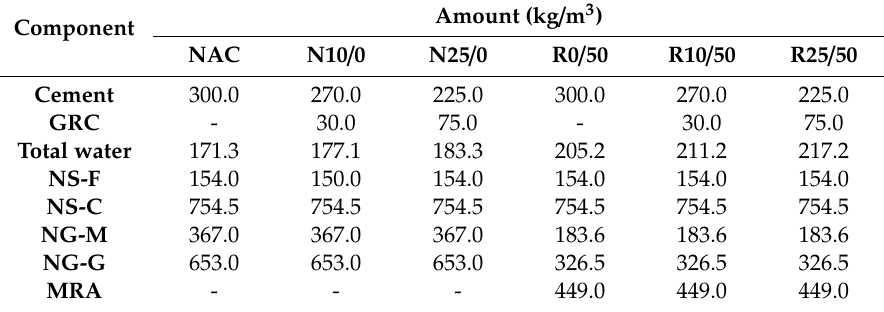
Table 6. Concrete mix design.